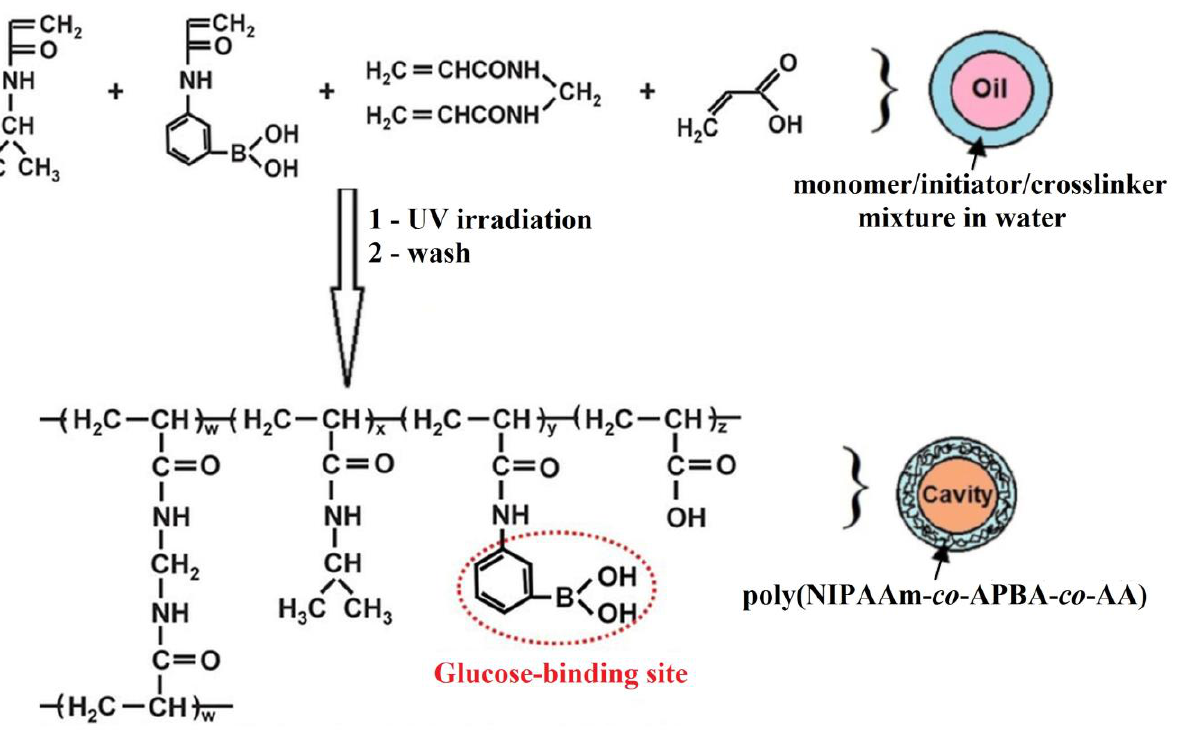
Figure 4. Preparation of poly(NIPAAm- co -APBA- co -AA) microcapsules (Adapted from reference [75] with permission from the Royal Society of Chemistry).